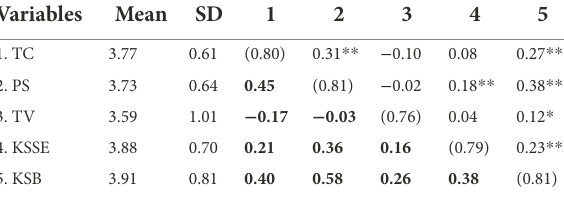
N I = 282. N T = 37. Square roots of AVE are displayed on the diagonal in parentheses. Values in bold are HTMT ratios of each pair of constructs.